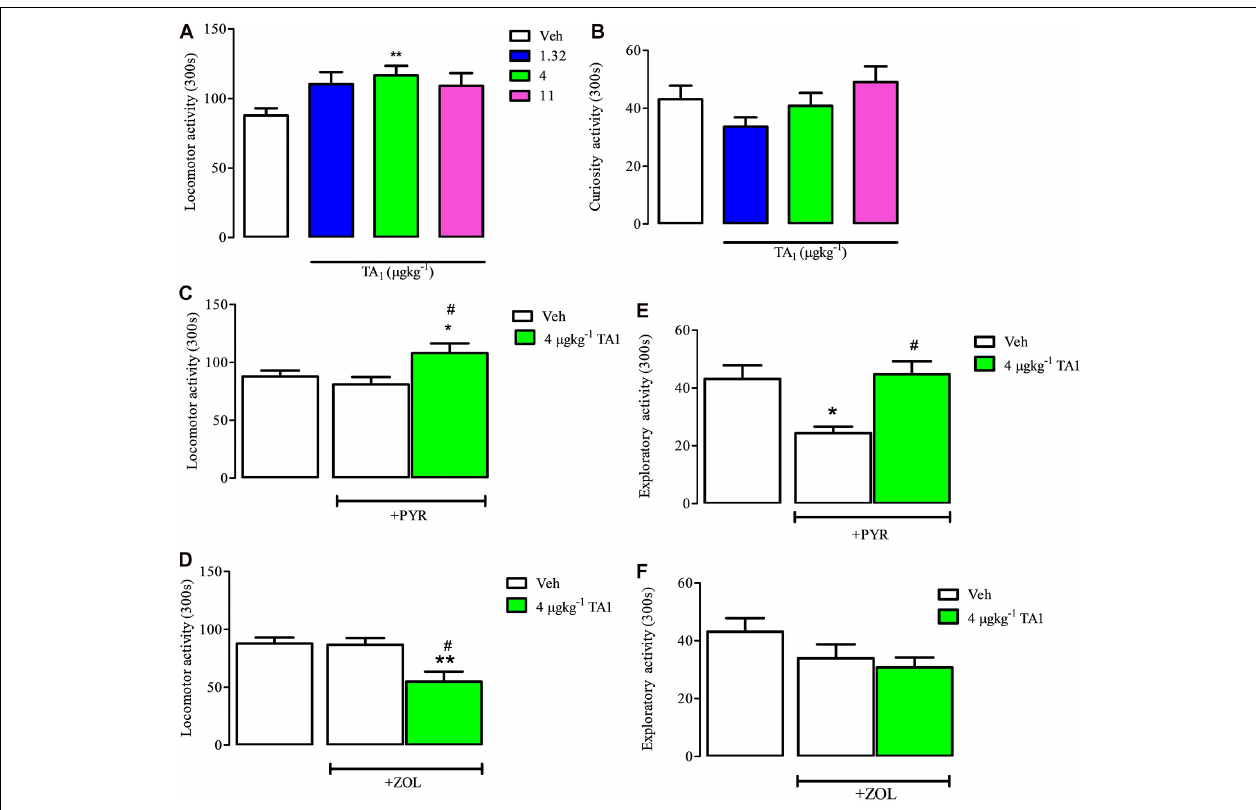
FIGURE 6 | TA1 increases mouse spontaneous locomotor activity: evidence for histamine involvement. Mice were put on the hole board 15 min after 1.32, 4, and 11 µ gkg − 1 TA1 administration to evaluate the effect of the treatments on spontaneous locomotor activity and exploratory activities. Results are expressed as the means ± SEM of measurements relative to 10 mice. (A,B) The effect of TA1 treatment on spontaneous mice locomotion (A) and exploratory activity (curiosity, B ) is showed ( ∗∗ P < 0.01 vs. One-way ANOVA test followed by Tukey Multiple Comparison Test). (C,D) Mice locomotion was evaluated in mice pre-treated i.p. with Veh or with pyrilamine (10 mgkg − 1 ; PYR; C ) or with zolantidine (5 mgkg − 1 ; ZOL; D ),before receiving 4 µ gkg − 1 TA1 or Veh as described in Methods. Results are the means ± SEM of measures relative to 10 mice ( ∗ P < 0.05 and ∗∗ P < 0.01 vs. Veh, # P < 0.05 vs. PYR/ZOL, One-was ANOVA test followed by Tukey Multiple Comparison Test). (E,F) Mice curiosity (exploratory activity) was evaluated in mice pre-treated with Veh or with PYR (E) or ZOL (F) before receiving 4 µ gkg − 1 TA1 or Veh. ( ∗ P < 0.05 and # P < 0.05 vs. PYR, One-way ANOVA test followed by Tukey Multiple Comparison